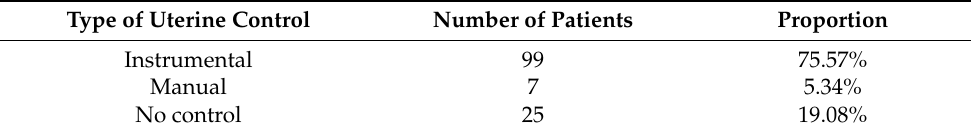
Table 16. Distribution of patients regarding the type of uterine cavity control.